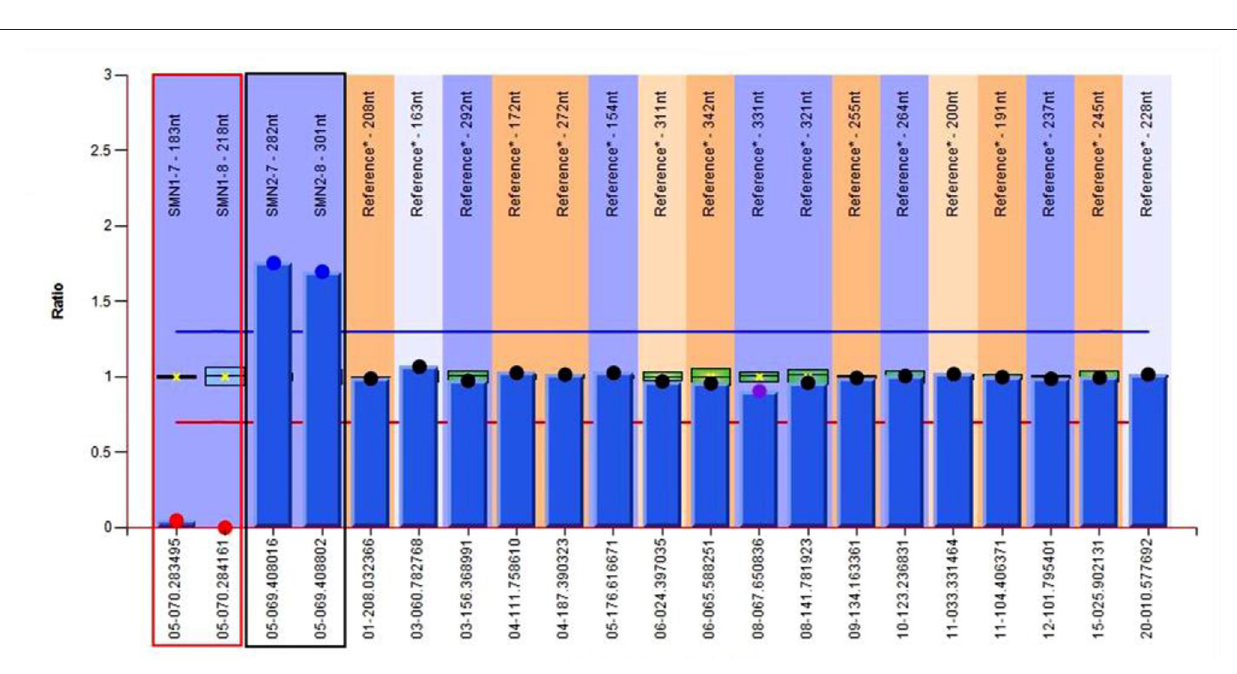
FIGURE 5 | Genetic test results of the patient show 0 copy of exons 7 and 8 of SMN1 , 3 copies of exons 7 and 8 of SMN2 . The red region refers to exons 7 and 8 of SMN1 , and the black one refers to exons 7 and 8 of SMN2